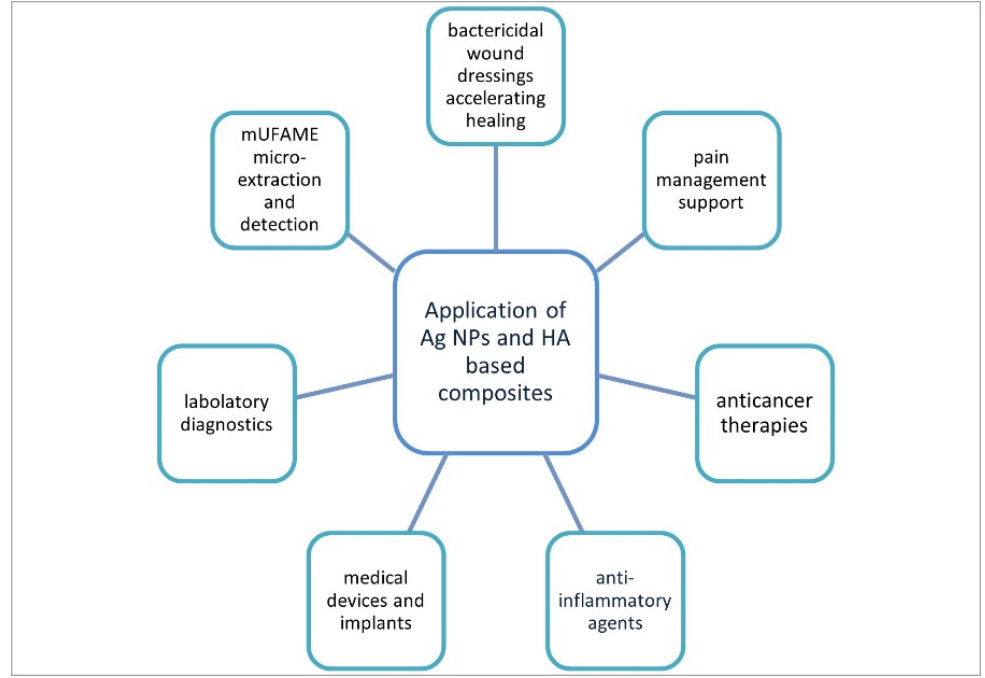
Figure 4. Potential application and usage of silver nanoparticles and hyaluronic acid-based composites; mUFAME—monounsaturated fatty acid methyl esters.